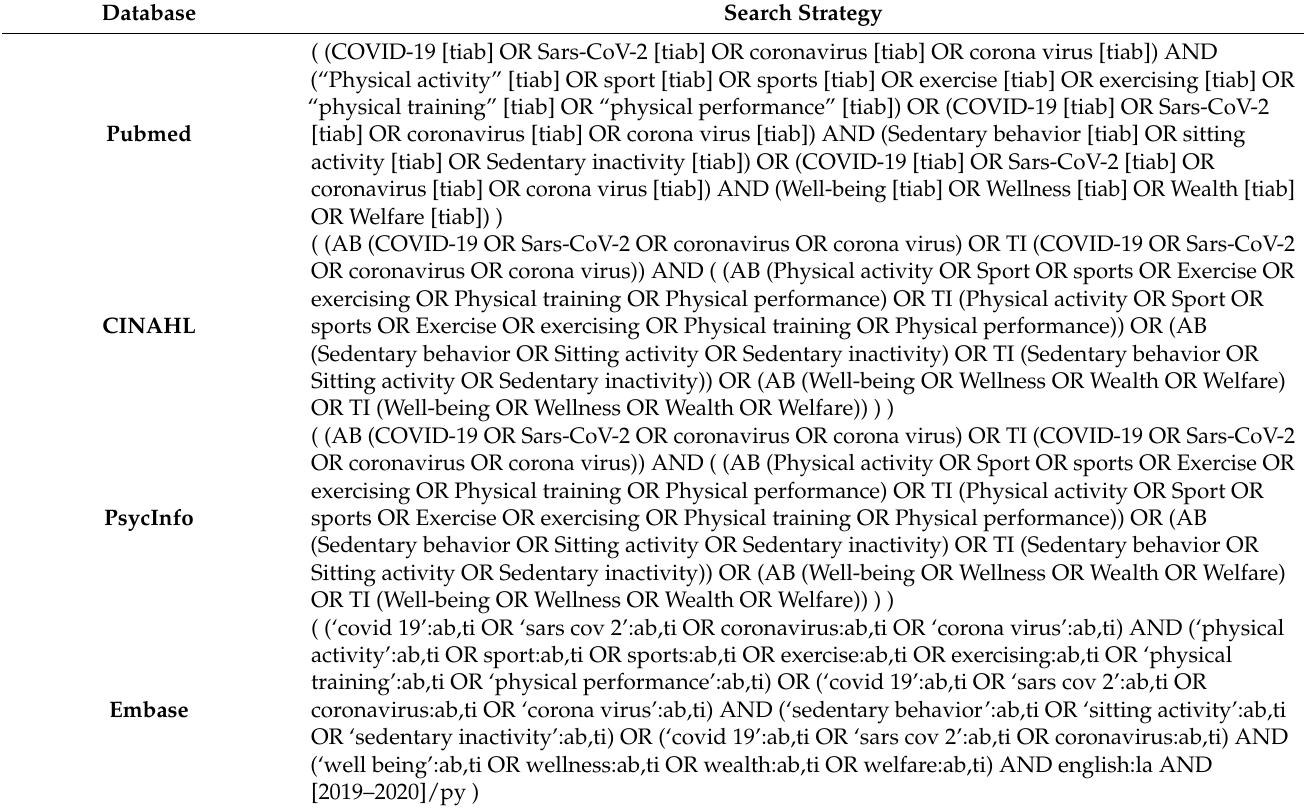
Table A1. Details of the search strategies.